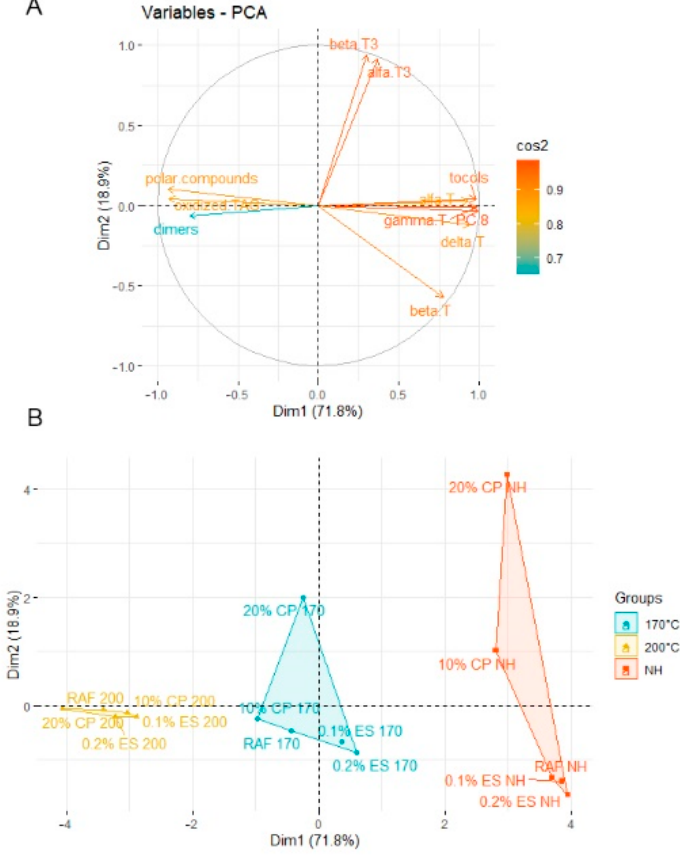
Figure 3. The changes Score plot ( A ) and loading plot ( B ) of principal component analysis (PCA) for data from α -, β -, γ -, and δ -tocopherols (T), plastochromanol-8 (PC-8), tocochromanols (tocol), total polar compounds (TPC), oxidized triacylglycerol (oxidized TAG), and dimers triacylglycerol (di- mers TAG).